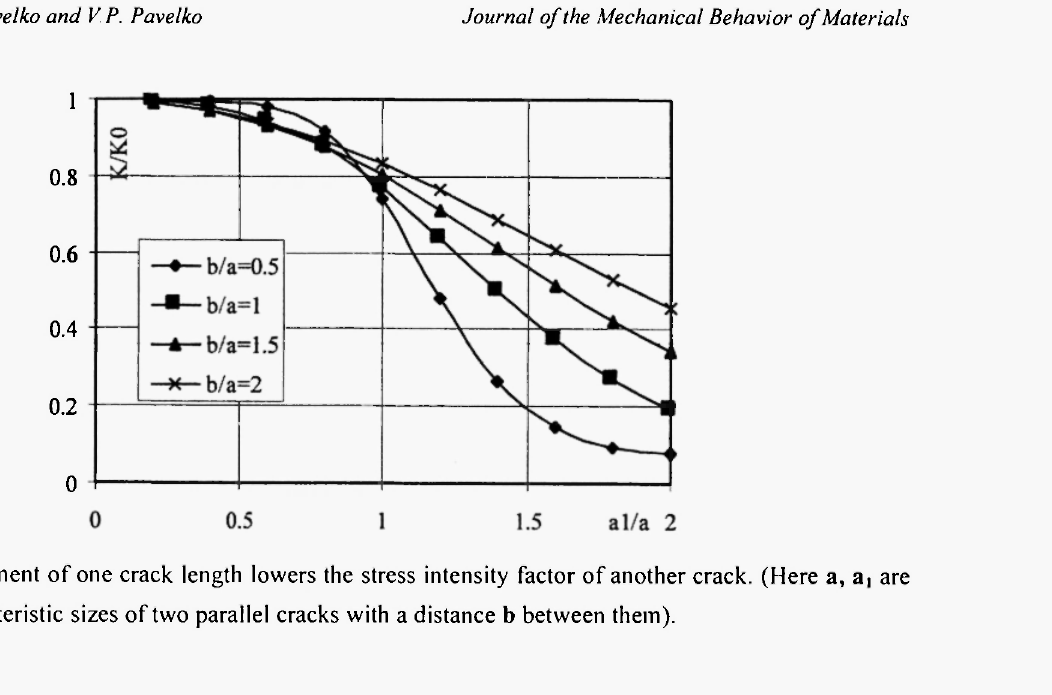
Fig. 9: The increment of one crack length lowers the stress intensity factor of another crack. (Here a, a, are the characteristic sizes of two parallel cracks with a distance b between